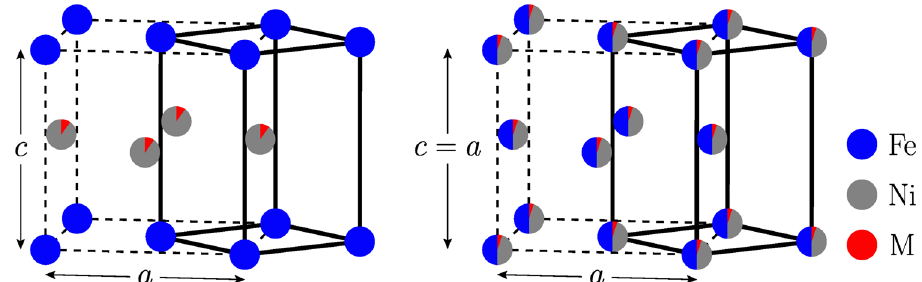
Figure 1. Left panel shows the alloyed L1 0 FeNi 1 − x M x ( M = Al, Ti, Cr, Co, Mo) structure ( η = 1 ) and the right panel shows the fully random (fcc) structure ( η = 0 ). Blue atoms are Fe and gray atoms Ni. The letter M and the red part of the atomic sphere indicate the alloying element and its concentration. The convention for the a and c lattice parameters is